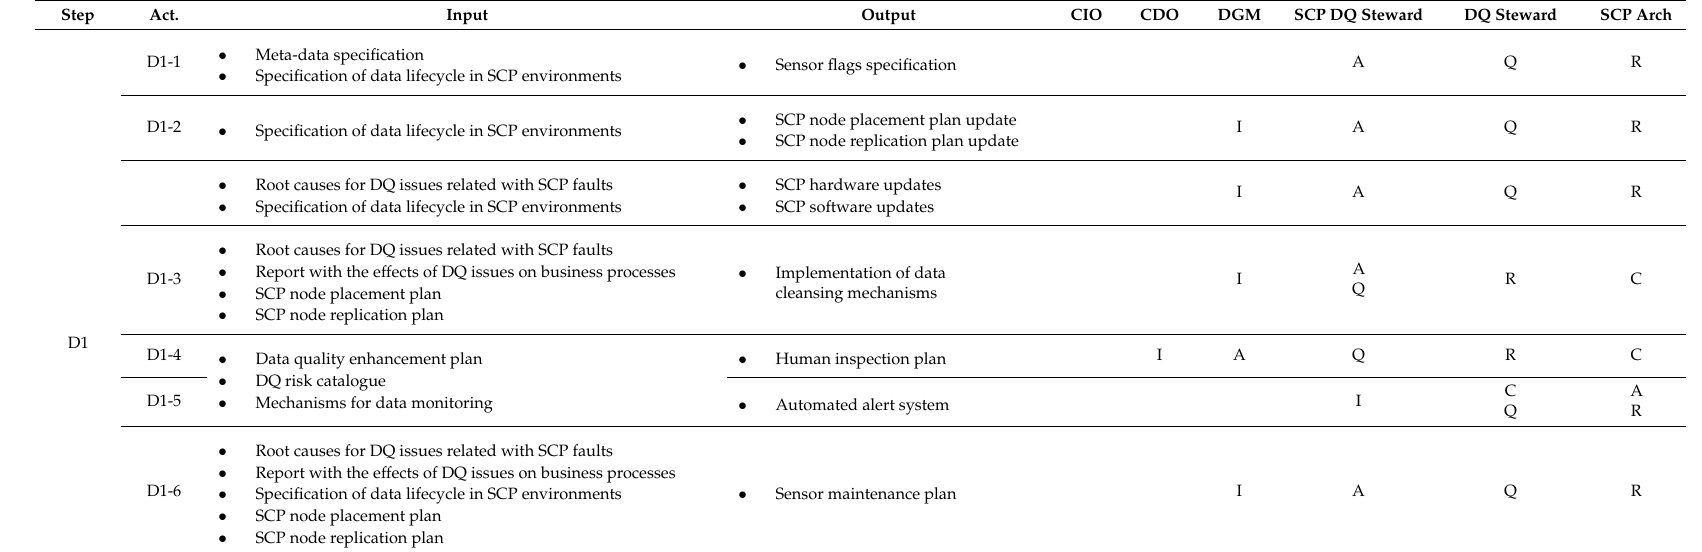
Table 6. Inputs, outputs and RACIQ matrix for the Do phase. (R—Responsible (works on); A—Accountable, C—Consulted; I—Informed; Q—Quality Reviewer). Step Act.